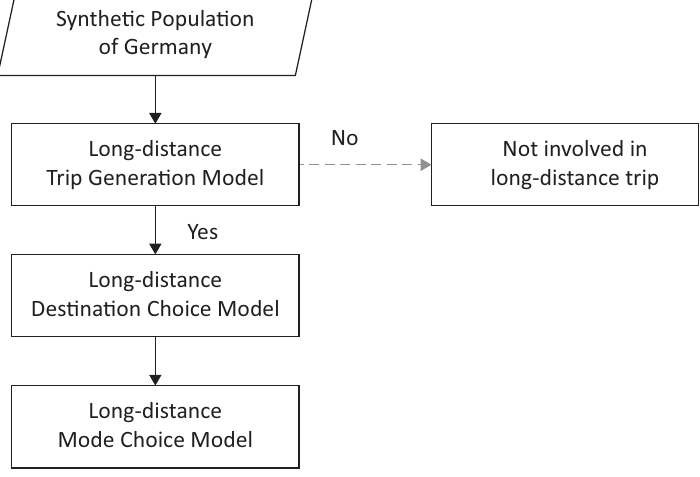
Figure 1. Model framework.